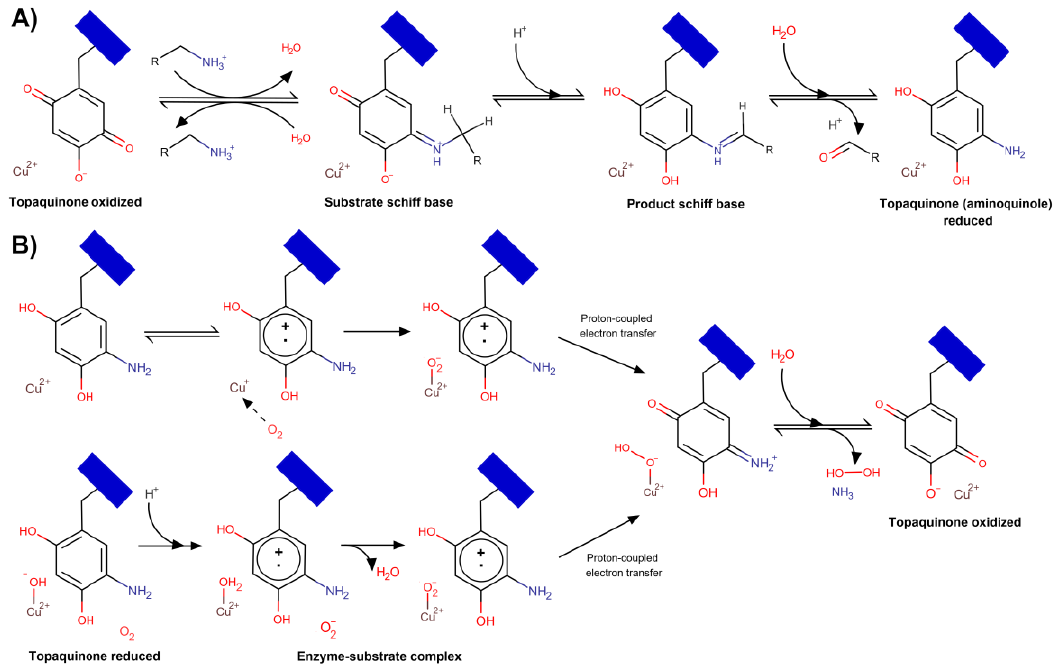
Figure 2. Proposed AOC catalytic mechanism. ( A ) Mechanism of reductive half-reaction; ( B ) two proposed mechanisms of oxidative half-reaction; inner-sphere electron transfer pathway is shown above, while the outer-sphere is below. Protein represented as a blue rectangle. Based on the schemes presented in [31].